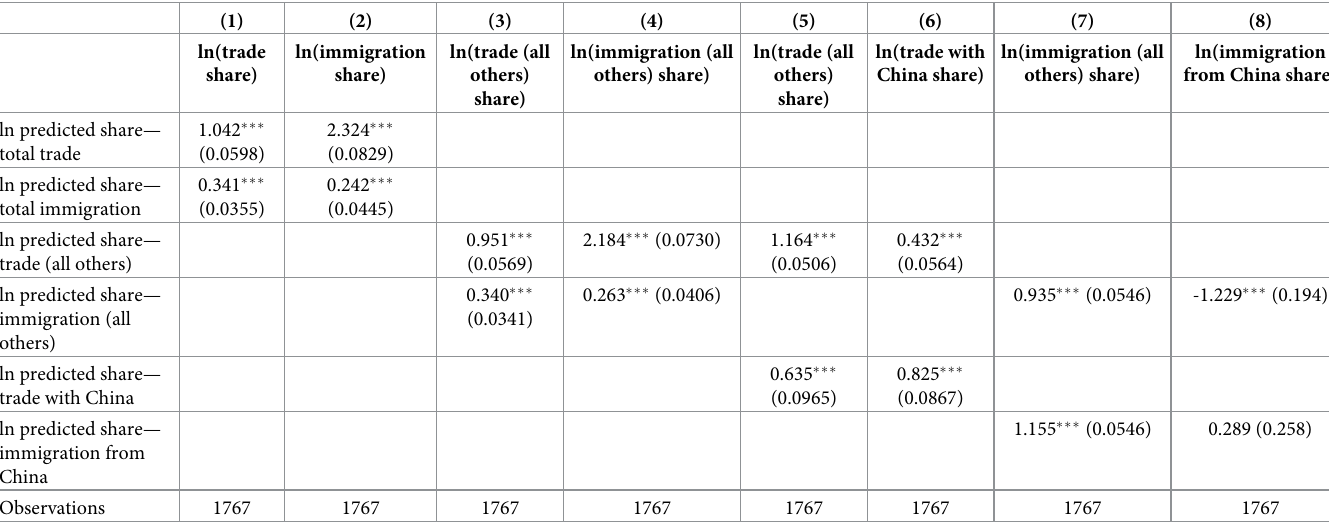
Table 3. Discrimination, openness to trade and immigration: 1st-stage